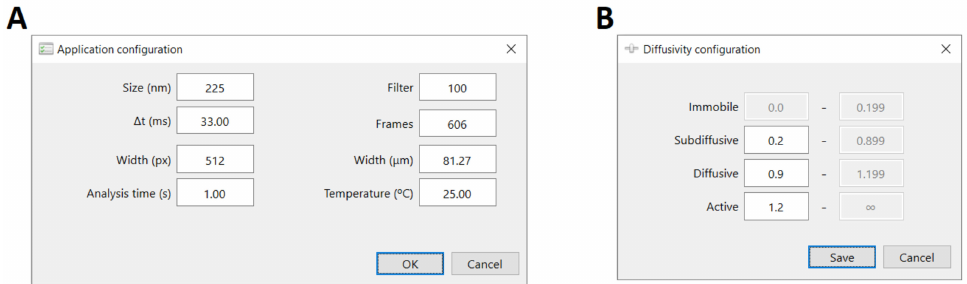
Figure 3. Input configuration parameters of MPTHub. Panels used by the user for defining ( A ) ex- perimental conditions (particle size, temperature), input video properties (field width in pixels and micrometers, temporal resolution, and total length in frames), and analysis parameters (minimum num- ber of consecutive frames needed to define valid trajectories (filter), and analysis time), and ( B ) range for the anomalous diffusion exponent in order to define transport